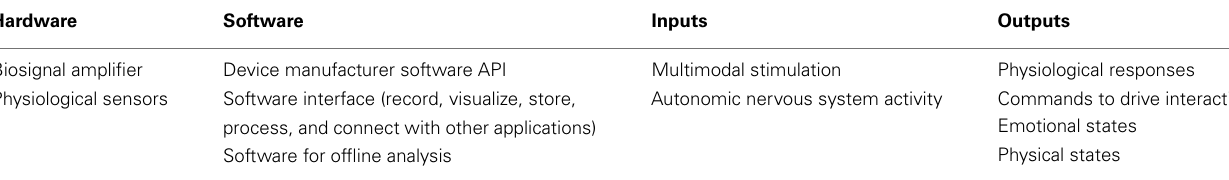
Table 4 | Characteristics of the physiological measurement module .